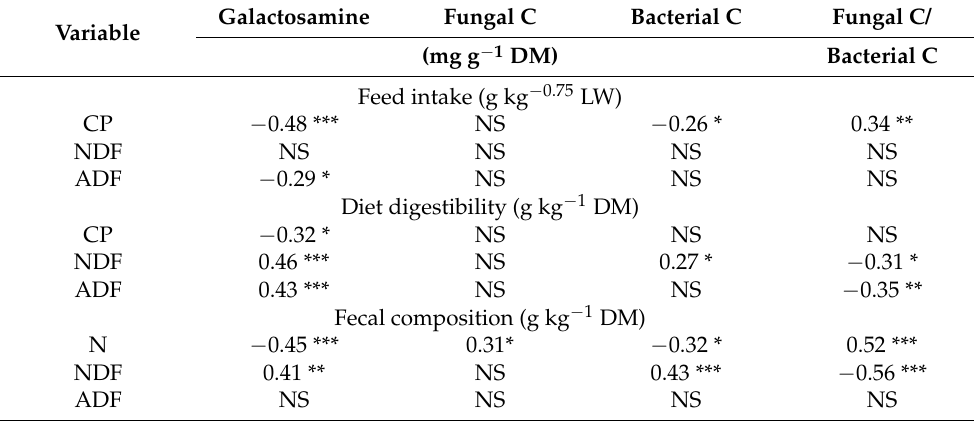
Table 6. Pearson’s correlation coefficients between fecal concentrations of galactosamine, fungal C, bacterial and microbial C as well as intake, ingesta composition, diet digestibility and fecal composition, across experiment 1 and experiment 2 data